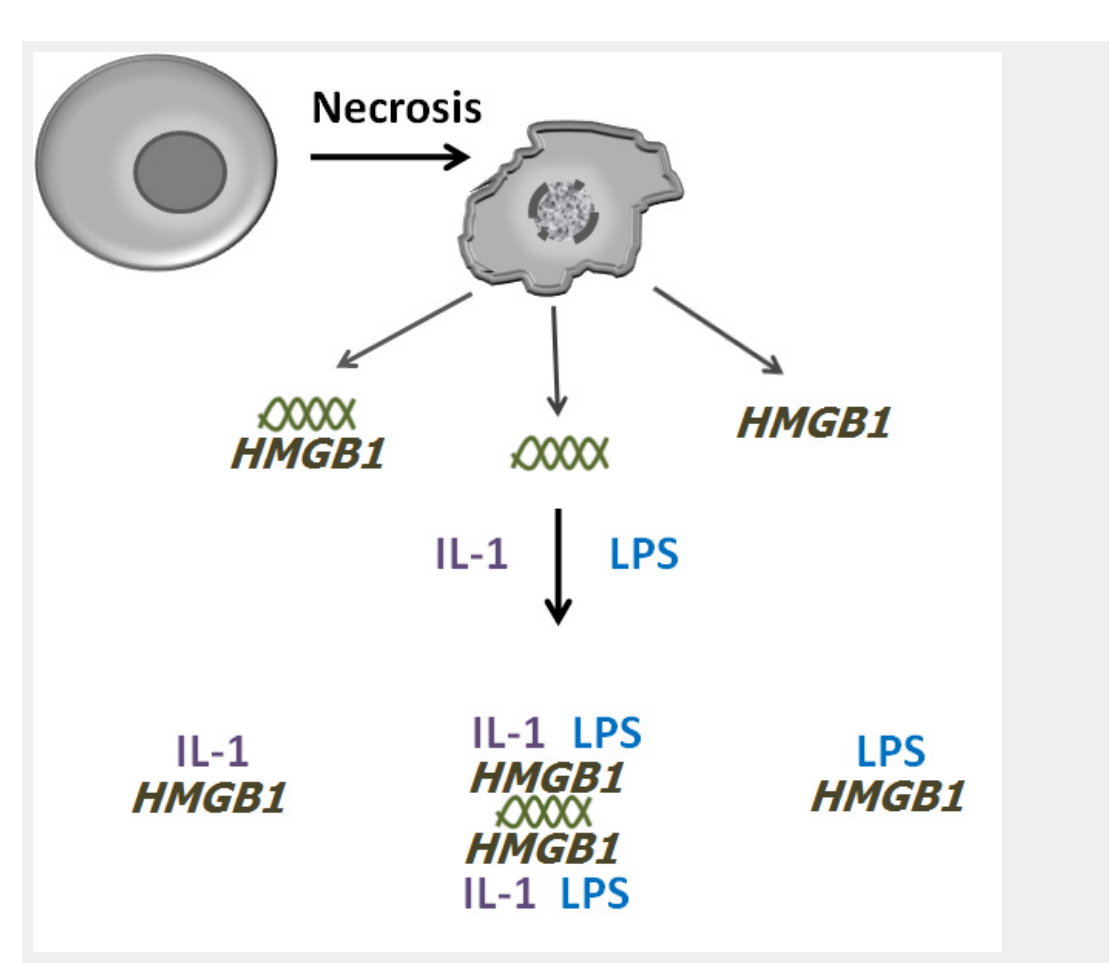
Figure 2 The formation of DAMP-PAMP complexes with HMGB1. The figure depicts a model by which HMGB1 can form complexes with DAMPs, PAMPs and cytokines following cell death. During necrosis in the setting of infection, both HMGB1 and DNA (illustrated by the double helix) can exit cells, alone or as a complex. Once in the extracellular milieu, HMGB1 can bind to molecules such as IL-1 and LPS and, depending on its interactions with DNA, can form complexes of varying structure and with a varying the number of components. The large complex illustrated is hypothetical although experimental data have demonstrated complexes of HMGB1 with DNA, IL-1 and LPS. This model allows the generation of many types of complexes that could vary depending on the components and the stoichiometry. For simplicity, the array of such complexes is not